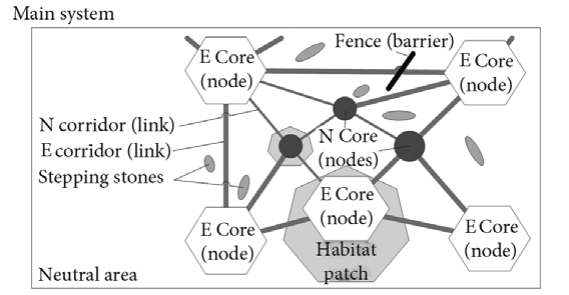
Fig. 1. Spatial graph-based structural elements of ecologically compensating infrastructure used for construction of ecological network for barrier (fence to keep animals of the road) impact analysis (E – European, N –